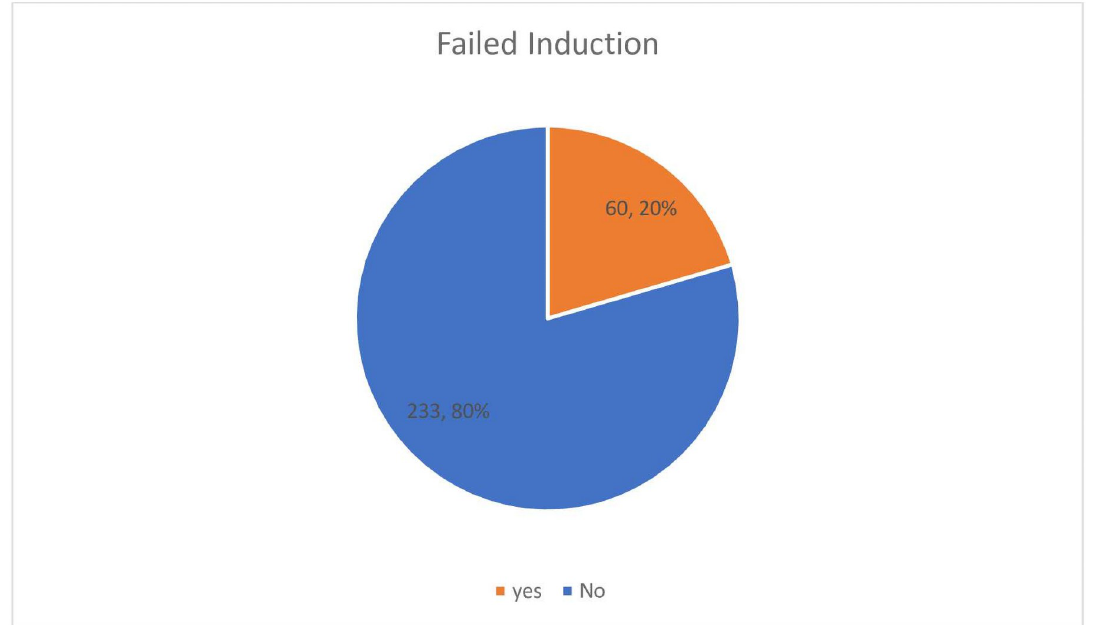
Fig 1. Prevalence of failed induction among study participants in Adama Hospital Medical College. East Shoa, Oromia, Ethiopia, 2020.